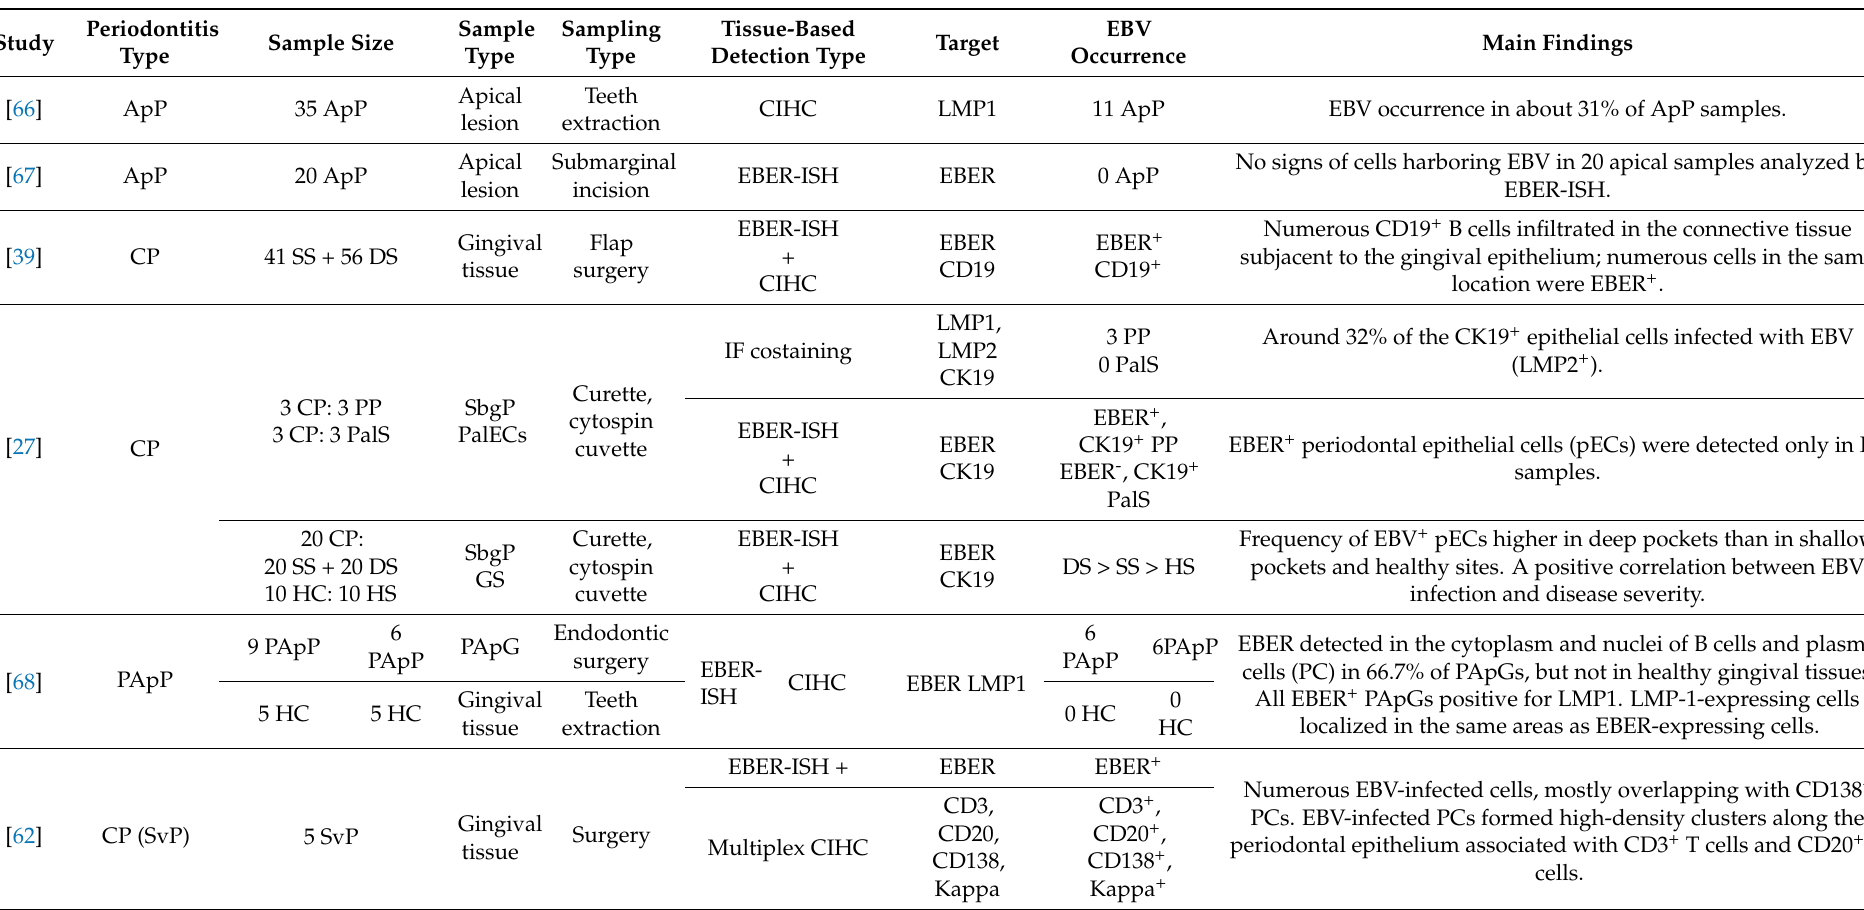
Table 2. Characteristics of the studies using tissue-based detection